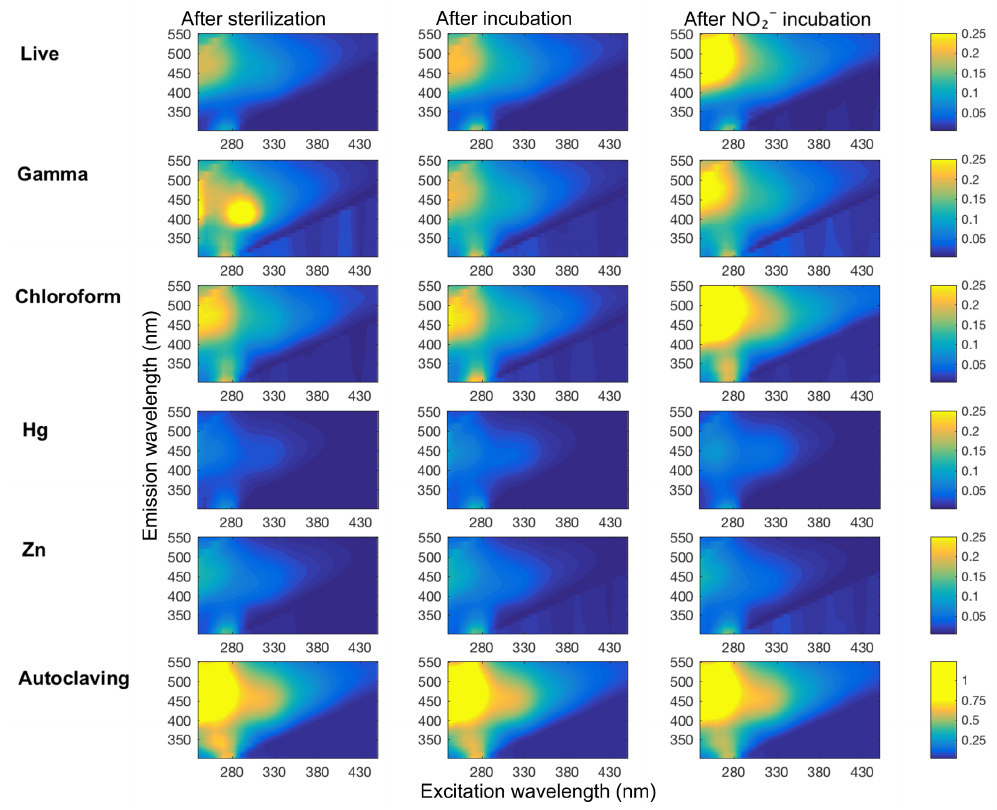
Figure 4. Representative plots of DOM fluorescence in soil slurry incubations of Quistococha peat soils. DOM fluorescence is presented as excitation–emission matrices (EEMs) collected for each treatment (rows) after the sterilization procedure or live control (left column), after incubation with no amendment (“after incubation” control, middle column), and after incubation with 300µMNO − as control, right column). The colored bar shows the individual signal intensity. All but the “autoclaving” treatment have same scale of signal intensity, autoclaving effects increased to about 5 times the signal intensity scale. Treatments are as in the legend of Fig.